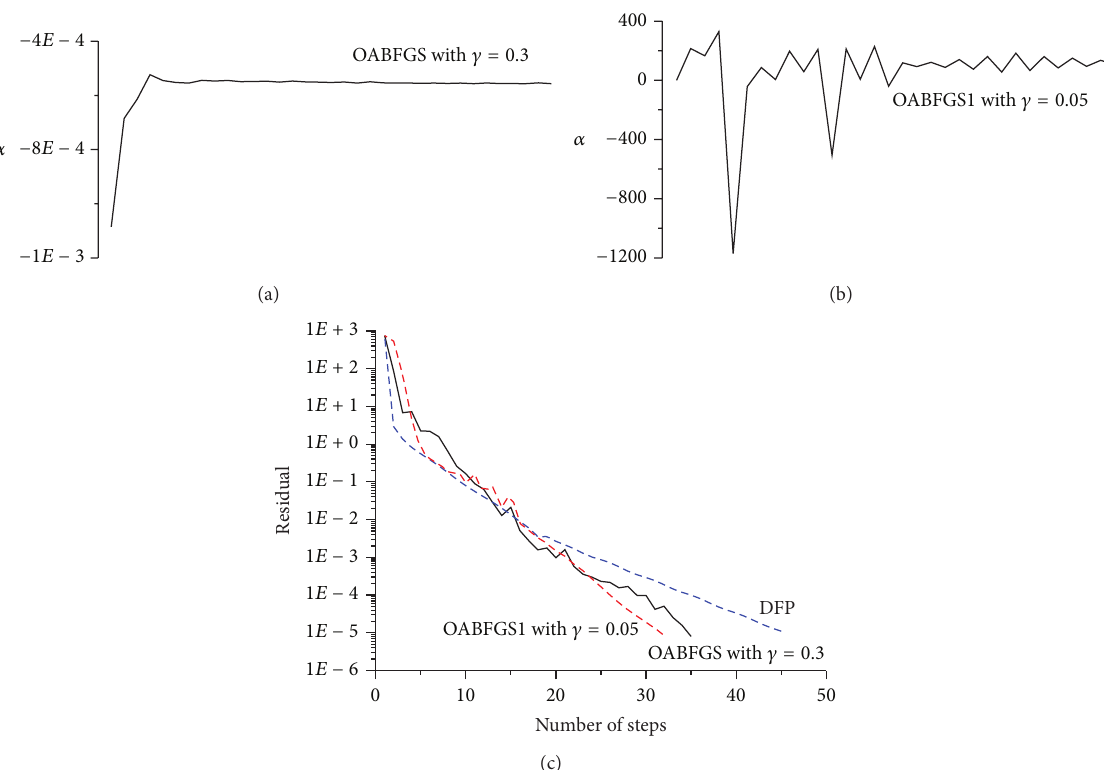
OABFGS with 𝛾 = 0.3